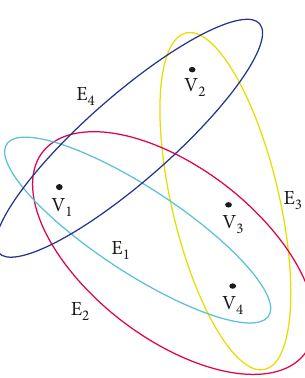
Figure 9: Regular double dominating set D